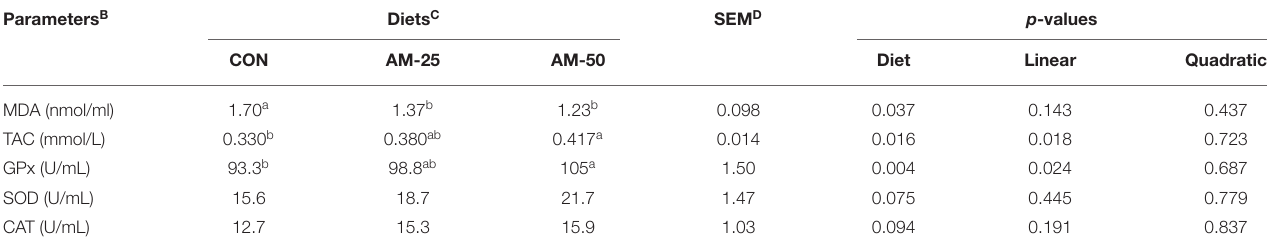
TABLE 4 | Antioxidant status of growing camels fed experimental diets A . Parameters